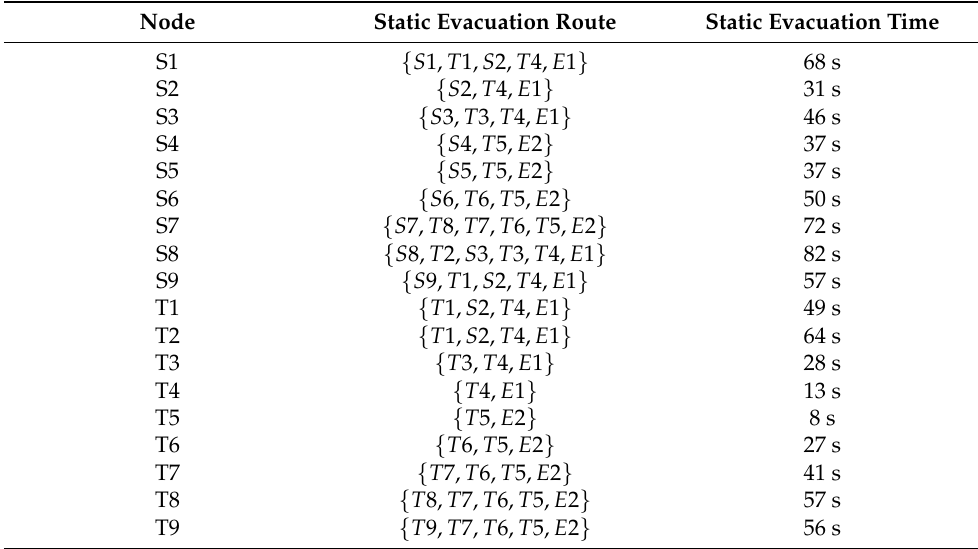
Table 3. Static evacuation routes and evacuation time required for people at each node.